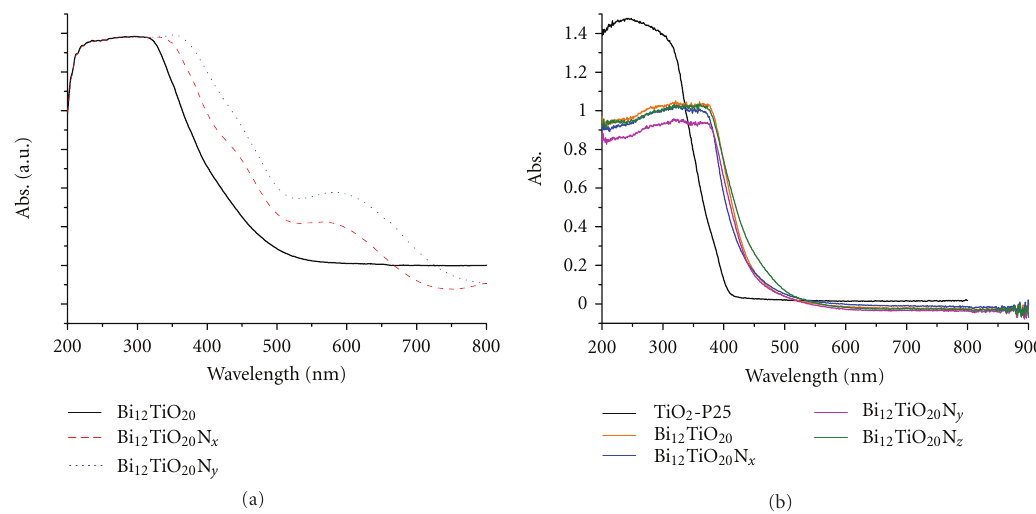
Figure 4: (a) Absorption spectra of films of bismuth titanate (Bi 12 TiO 20 , Bi 12 TiO 20 − x N x ( x = 0 . 01) and Bi 12 TiO 20 − y N y ( y = 0 . 03)) and (b) UV-Vis di ff use reflection spectra of powders Bi 12 TiO 20 , Bi 12 TiO 20 − x N x ( x = 0 . 01), Bi 12 TiO 20 − y N y ( y = 0 . 03), Bi 12 TiO 20 − z N z ( z = 0 . 06), and TiO 2